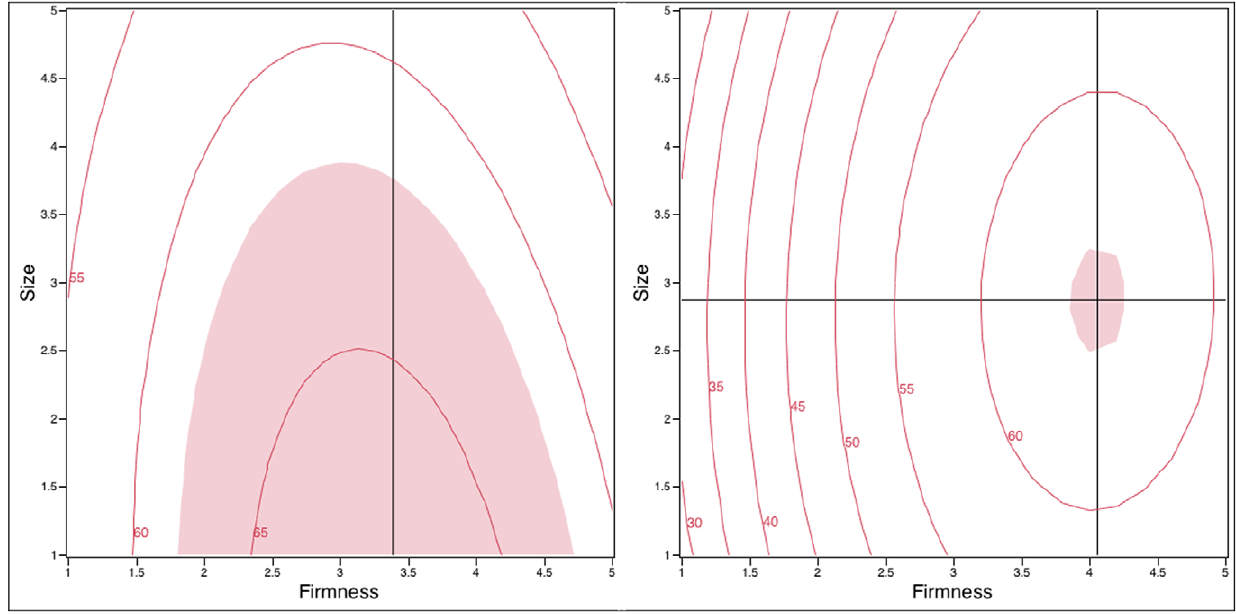
Figure 4. Contour plots of willingness (0–100) as a function of design variables (Firmness and Size) in the with-Applicator (left) and without-Applicator groups (right). The cross hairs indicate the location of the maximum value; the optimal size for the with-applicator group was below 1 (outside the design space) and is not shown. The shaded region is the same value (62.3) for both plots.